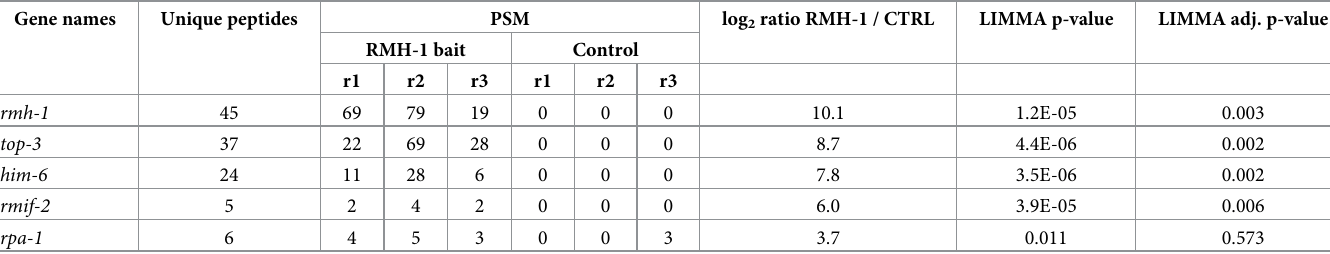
Table 1. Interacting proteins of RMH-1 as determined by affinity purification mass spectrometry. Gene names